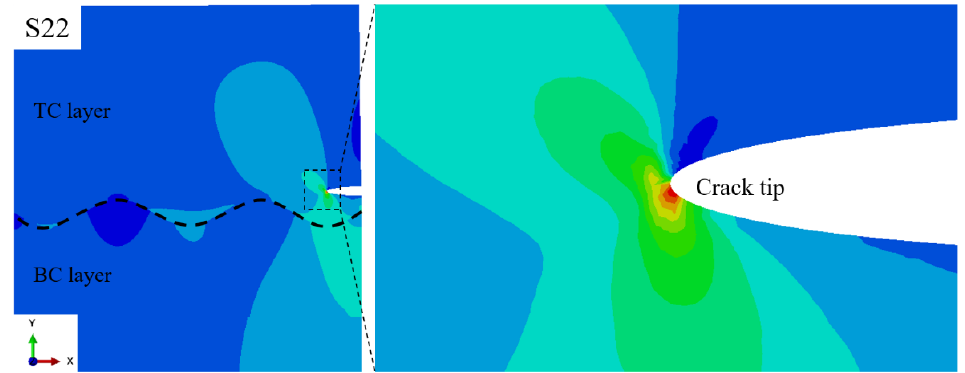
Figure 14. Stress (S22) distribution in coating at the end of heating stage during thermal cycling. The evolution of temperature and crack tip stress S22 of TBCs during the whole thermal shock process is shown in Figure 15. In the thermal shock heating stage, the stress at the crack tip increases with the increase of the sample temperature, and the maximum stress appears at the end of the heating stage. The stress in this process is a tensile stress perpendicular to the direction of crack propagation. The magnitude of the stress is an important factor driving the crack propagation. The elastic modulus of the ceramic layer has a significant effect on the stress level at the crack tip. When the elastic modulus increases from 20 GPa to 40 GPa and 60 GPa, the maximum stress S22 at the crack tip increases from 800 MPa to 1200 MPa and 1480 MPa, respectively.